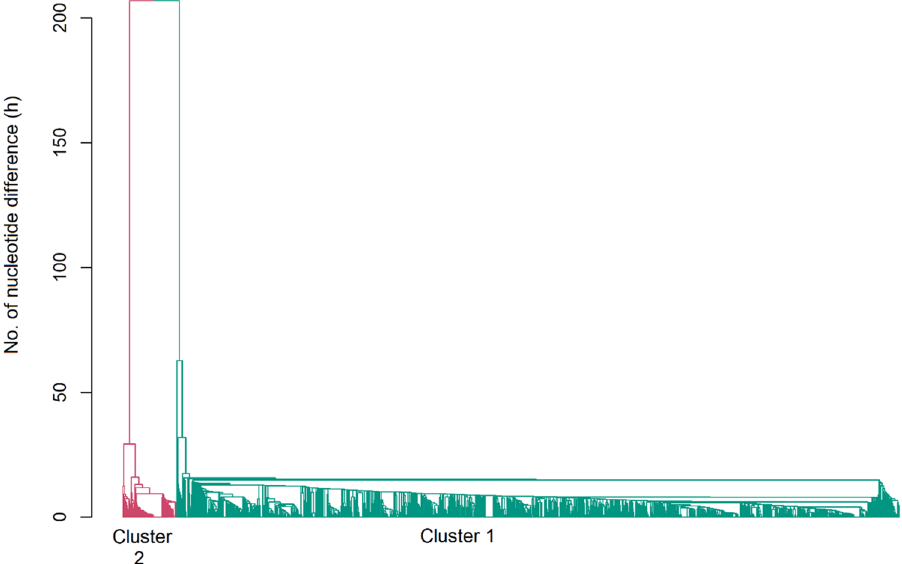
Figure 3. Hierarchical clustering of animals based on the number of nucleotide differences between the pair of mitochondrial sequences. Cluster 1 and 2 corresponded to taurus and indicus cattle, respectively.